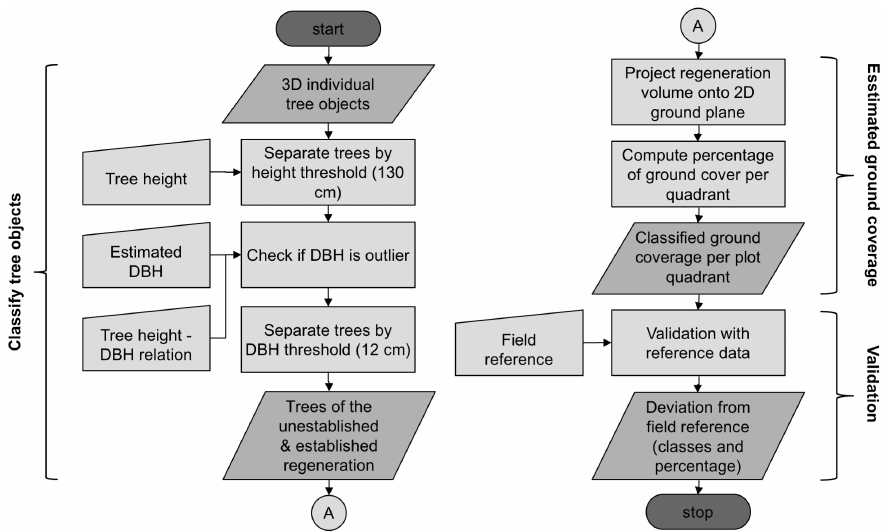
Figure 3. Flowchart explaining the estimation of regeneration ground cover. The process was separated into three parts which are indicated with braces at the side of the chart. Firstly, trees belonging to the unestablished and established regeneration were determined from the set of individual tree objects. Secondly, the percentage of ground cover was calculated from the 2D projection of the regeneration. Finally, the ground cover classes were validated using field reference data.